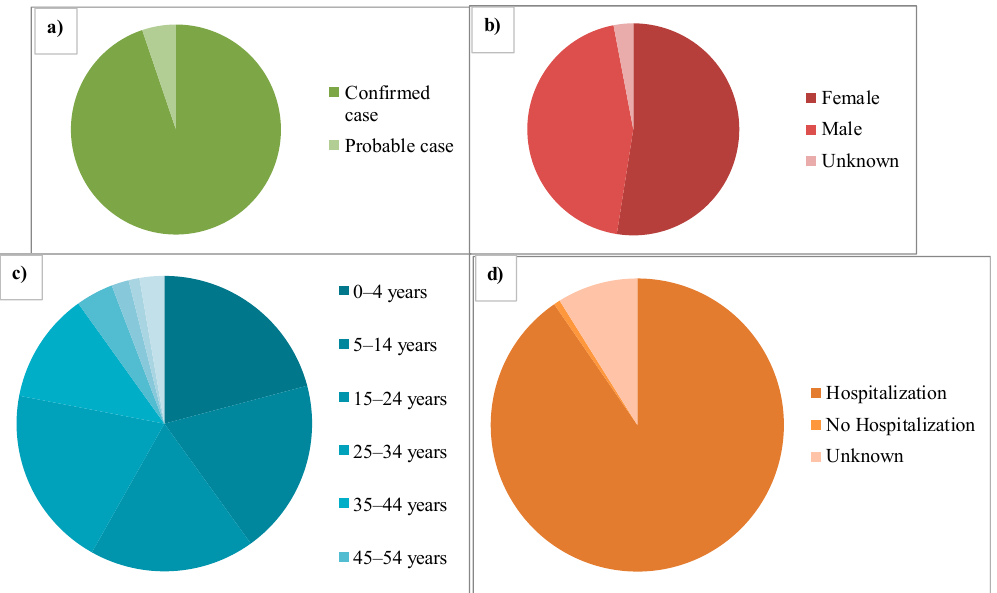
Figure 2. Demographic and epidemiologic characteristics of human cases with H5N1 virus infection by outcomes, between May 1997–April 2015. ( a ) Represents relative percentage of human cases based on types of cases, ( b ) shows relative percentage of human cases based on sex, ( c ) shows relative percentage of human cases based on age and ( d ) represents relative percentage of human cases based on